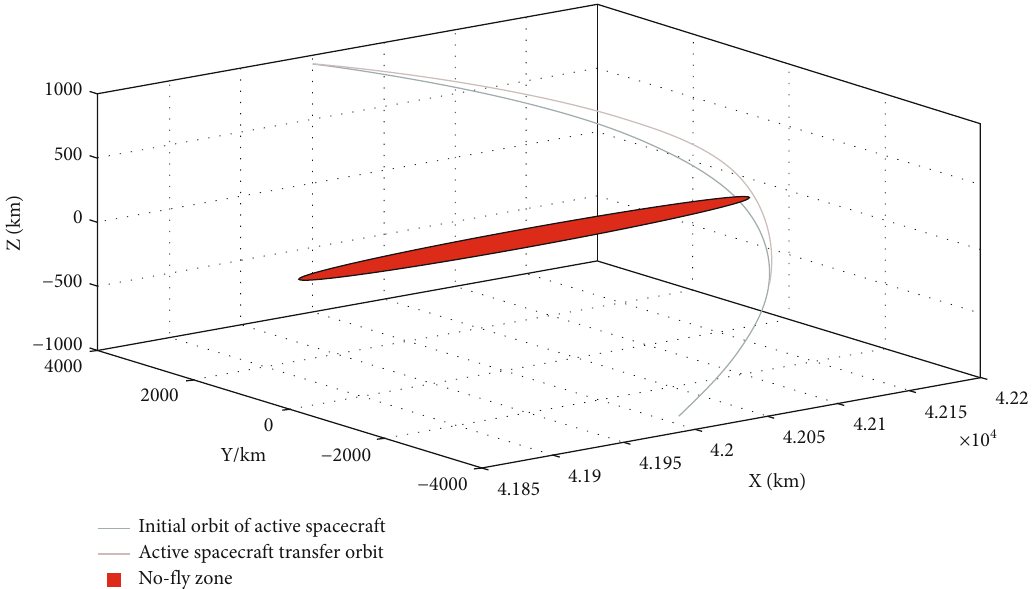
Figure 8: Active spacecraft transfers orbit based on the modi fi ed arti fi cial potential fi eld method.